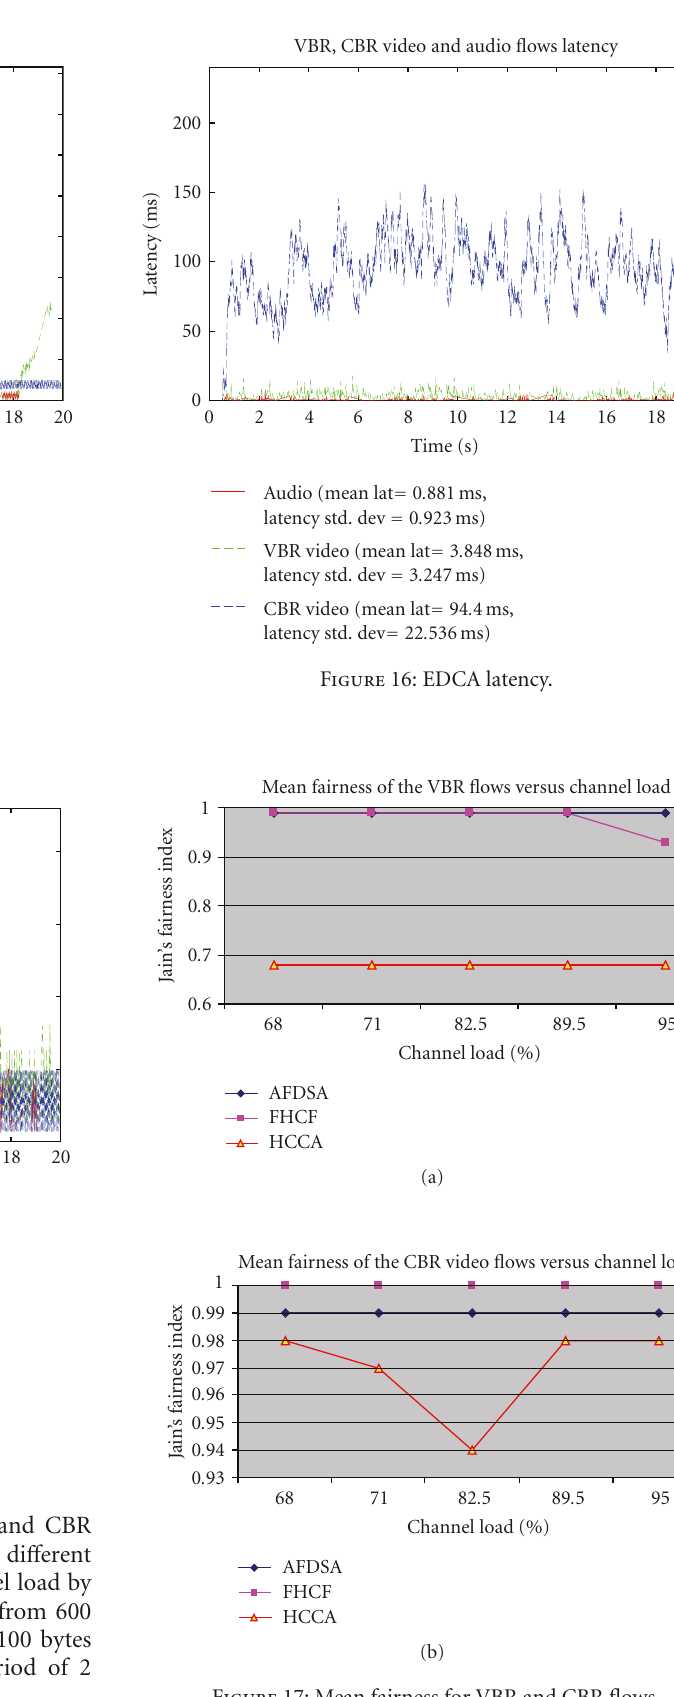
Figure 17: Mean fairness for VBR and CBR